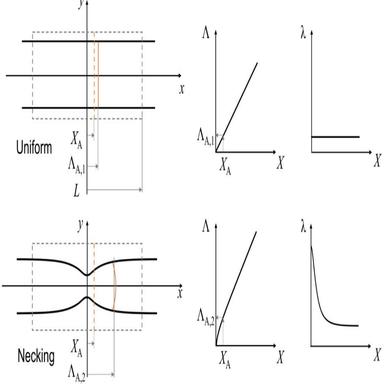
Comparison of mean axial position and axial stretch for a configuration in uniform deformation and one in the necking phase.